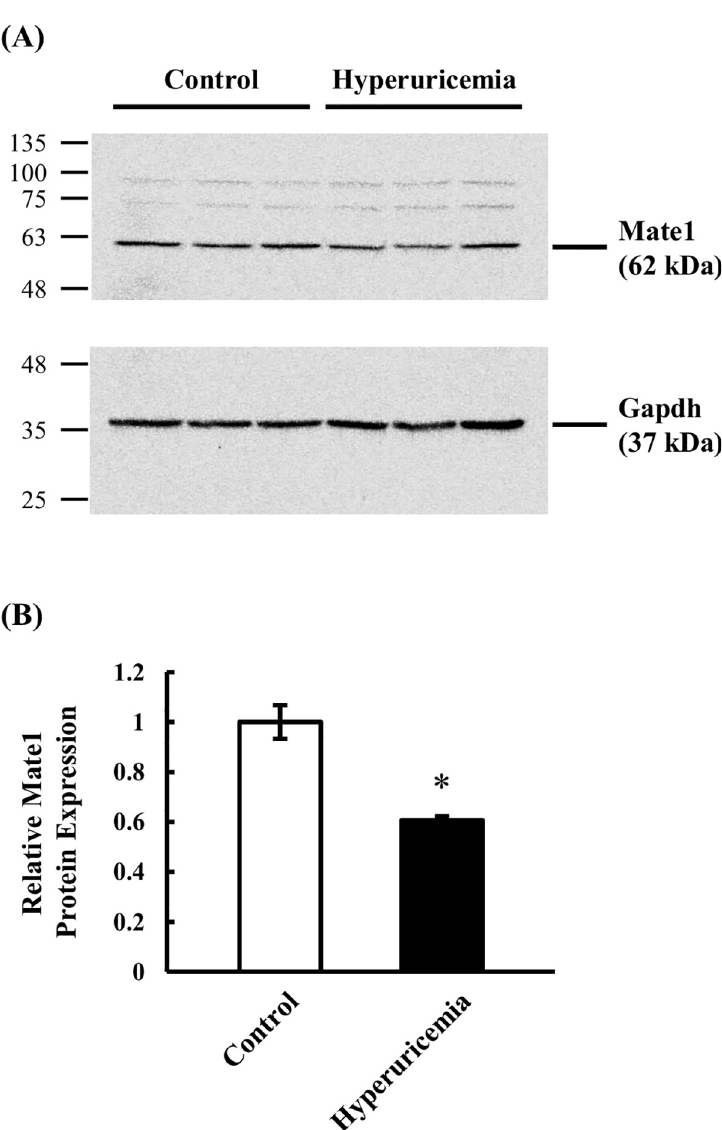
Fig 5. Protein expression level of kidney Mate1 in control and hyperuricemic rats. Western blot analysis was conducted using whole kidney lysate. (A) Typical result detected with anti-Mate1 and anti-Gapdh antibodies on the same membrane is shown. (B) Relative Mate1 density normalized to Gapdh density in hyperuricemic rats (closed column) are shown as the ratio to those in control rats (open column). Data are presented as mean ± SEM (n = 3). � p < 0.05 vs. control